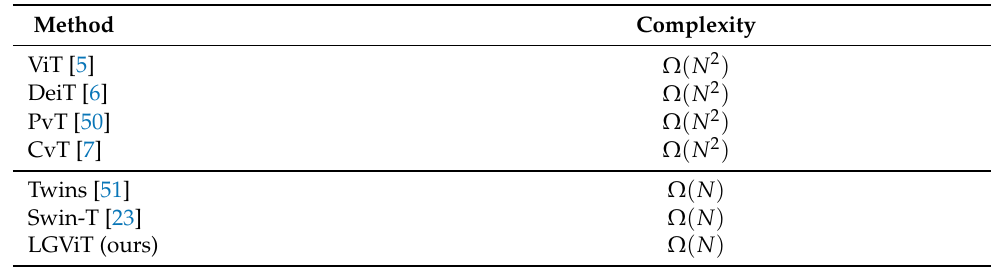
Table 2. Complexity comparison of different vision transformers. N = h × w , h and w are the height and width of the input image.